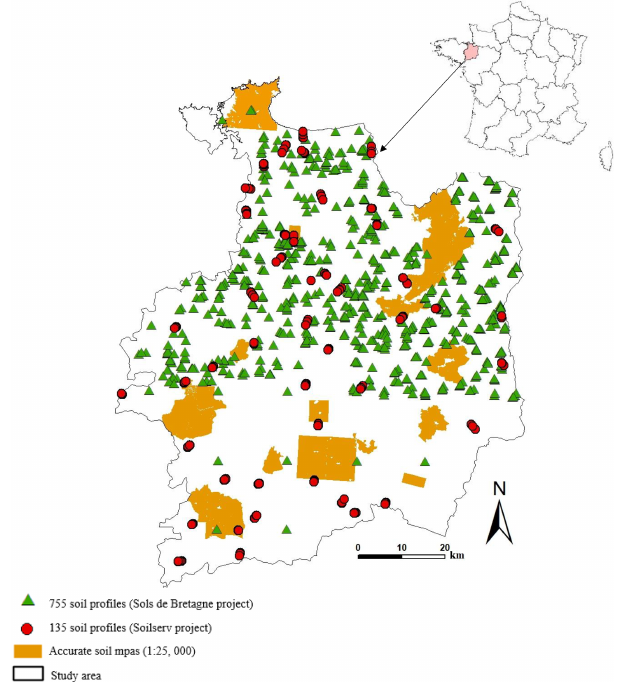
Figure 1. Location of the study area and the validation data